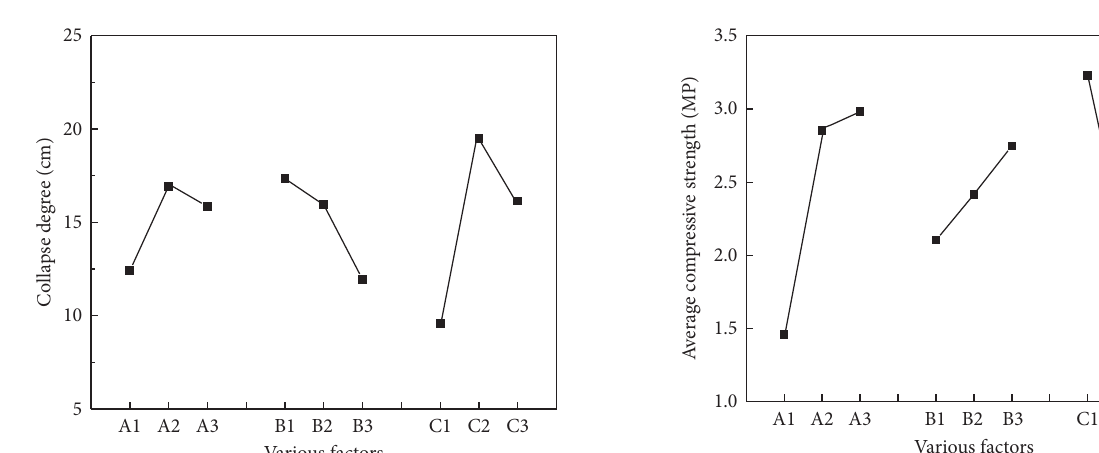
Figure 5: The tendency of collapsed slump and factor level of paste filling.